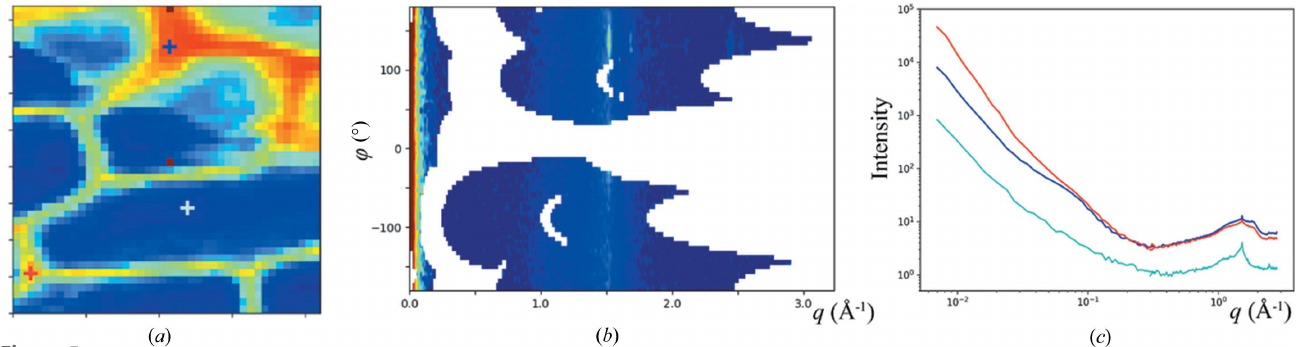
Figure 5 Scattering-based structural mapping of onion epidermal cells. ( a ) Map based on the overall scattering intensity at q > 0.1 A˚ (cid:6) 1 . Representative scattering data, corresponding to the location labeled by the cyan ‘+’ in ( a ), are shown in ( b ) as a merged q – ’ intensity map and using a logarithmic color scale. The azimuthally averaged data, from the three locations indicated by ‘+’ signs with the coreesponding color coding in ( a ) are shown in ( c ). The sharp feature at q ’ 1.5 A˚ (cid:6) 1 can be attributed to the naturally occurring